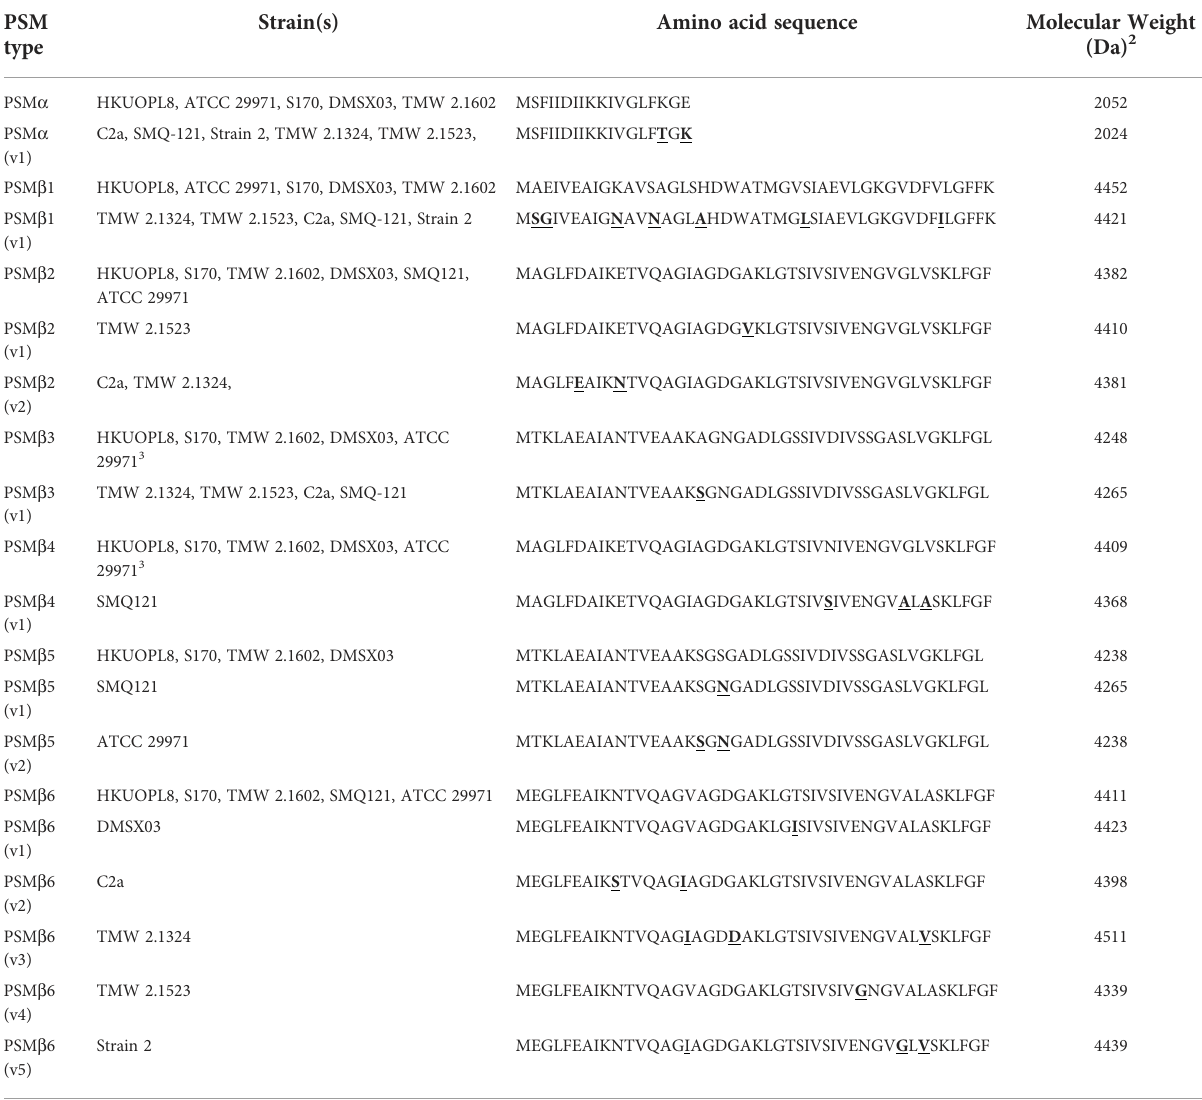
TABLE 1 Amino acid sequences of S. xylosus PSM peptides 1